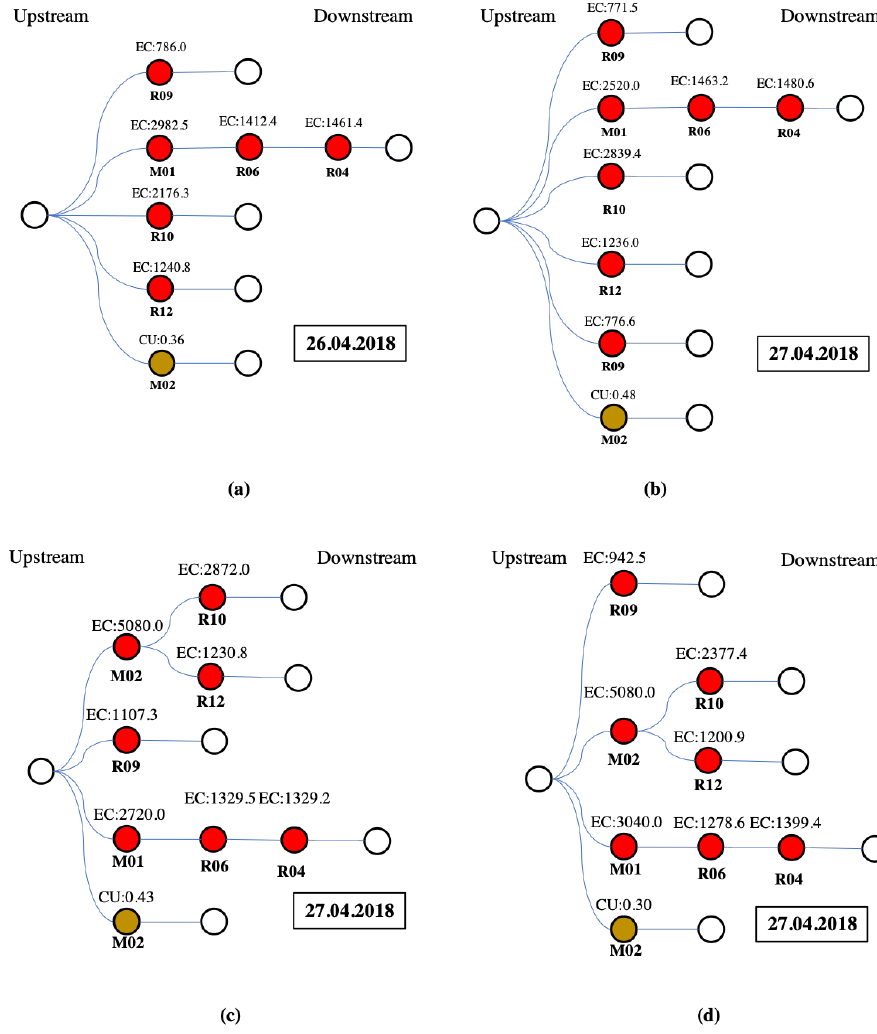
Figure7. Figure 7. Procedure trees for four monitoring stations with detected EC and Cu concentrations